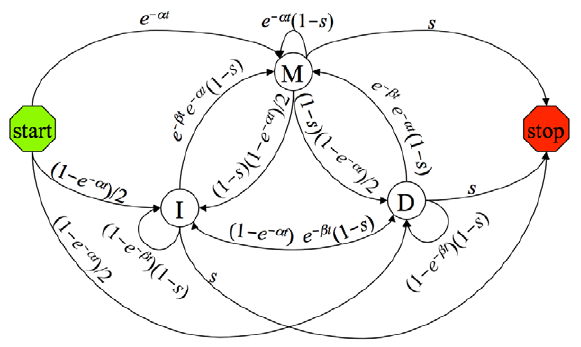
Figure 1. State-transition diagram for a PPHMM implementing a reversible and affine background indel model for a phylogeny branch of length t . Ovals denote emitting states; arrows denote transitions. Start and stop are special non-emitting states. This model can be implemented in 33 lines of SEAL code. Parameter s =1 - (1 - b ‘ )(1 - b ( t )) gives the probability of leaving the background model, for gain-of-function probability b ( t ), b ‘ = lim t R ‘ b ( t ). Parameters a and b influence indel